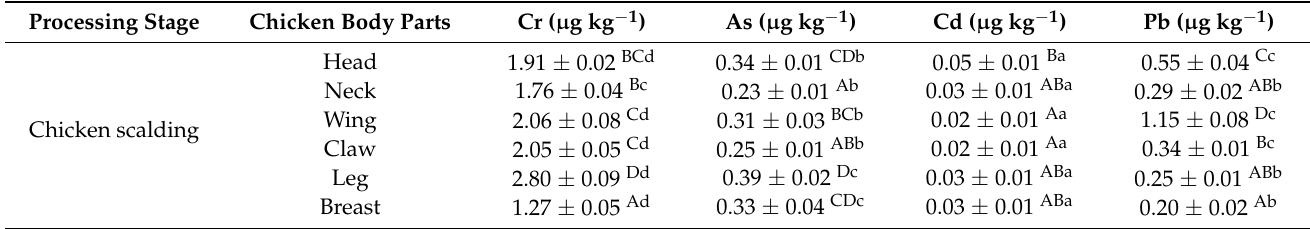
Table 4. Toxic elements in different body parts of chicken during the processing